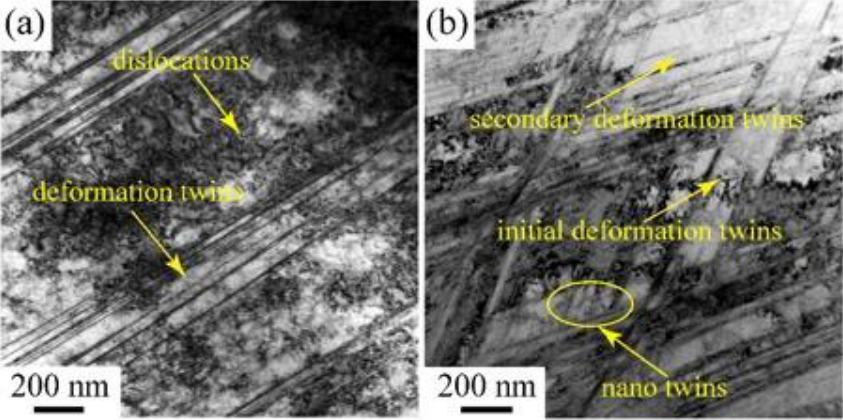
Figure 6. TEM images of Fe – 19Mn – 0.6C TWIP steel at ( a ) 5% and ( b ) 75% CR deformation.